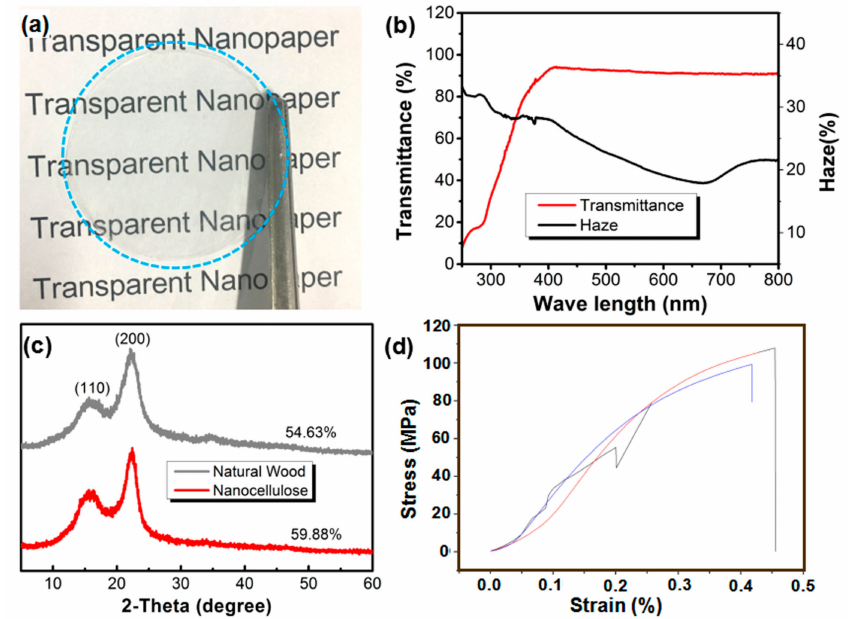
Figure 3. The transparent nanopaper: ( a ) digital photo of the nanopaper; ( b ) the transmittance and haze of the nanopaper; ( c ) the XRD patterns of the natural wood and nanocellulose; ( d ) the tensile stress of the nanopaper (tested three